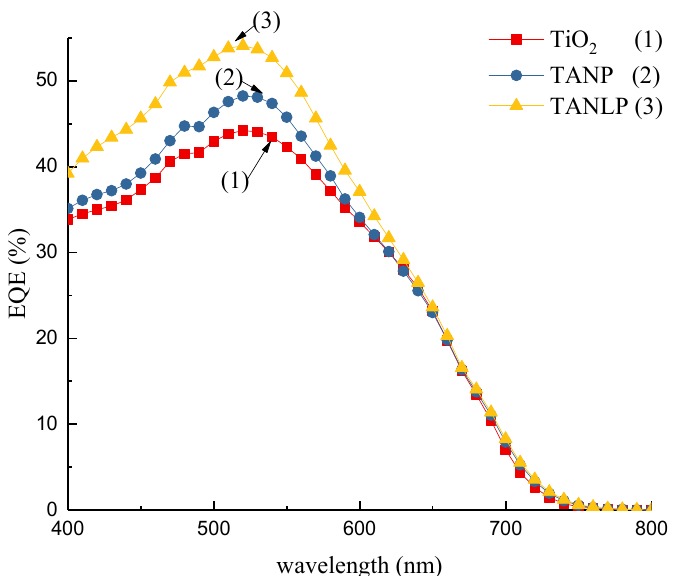
Figure 9. The Incident Photon-to-electron Conversion E ffi ciency (IPCE) spectrum for DSSCs with di ff erent